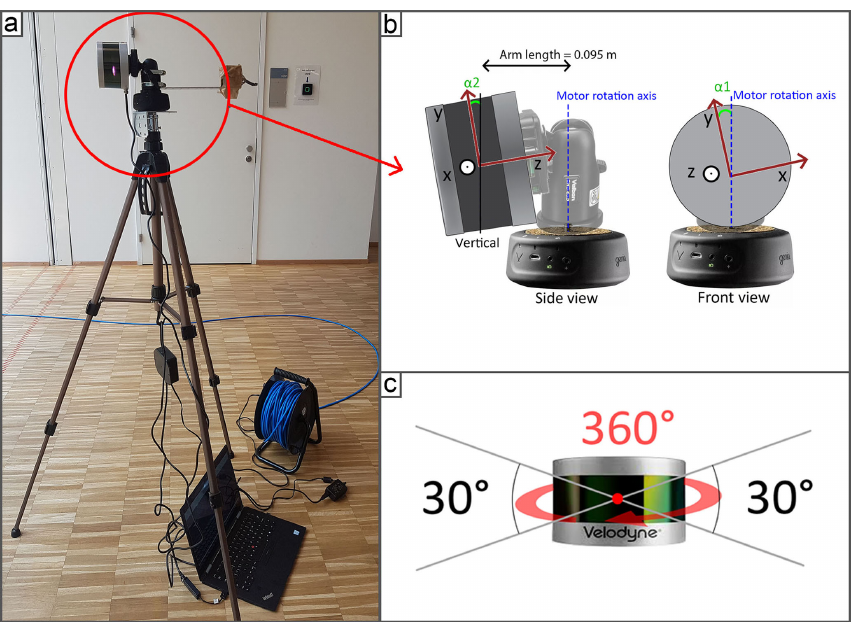
Figure 2. (a) Terrestrial lidar system (TLS); (b) two adjustments angles: collimation axis ( α 1 ) and tilting axis ( α 2 ) between the system and the rotation axis; (c) field of view of the VLP-16.